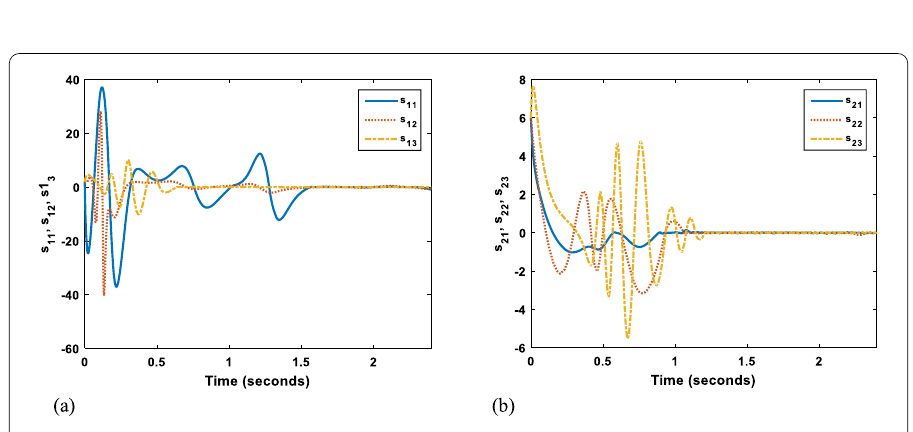
Figure 7 State trajectories of the sliding surface: ( a ) S 11 ( t ), S 12 ( t ), S 13 ( t ) and ( b ) S 21 ( t ), S 22 ( t ), S 23 ( t )